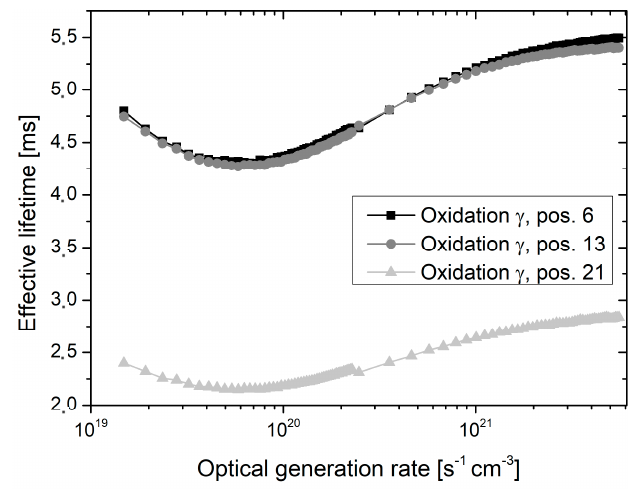
Figure 9. Effective lifetime as a function of the optical generation rate measured in the center of wafers, which were extracted from oxidation run γ and placed in quartz boat positions 6, 13, and 21, respectively. Quartz boat position 21 is located in direction of the tube door.